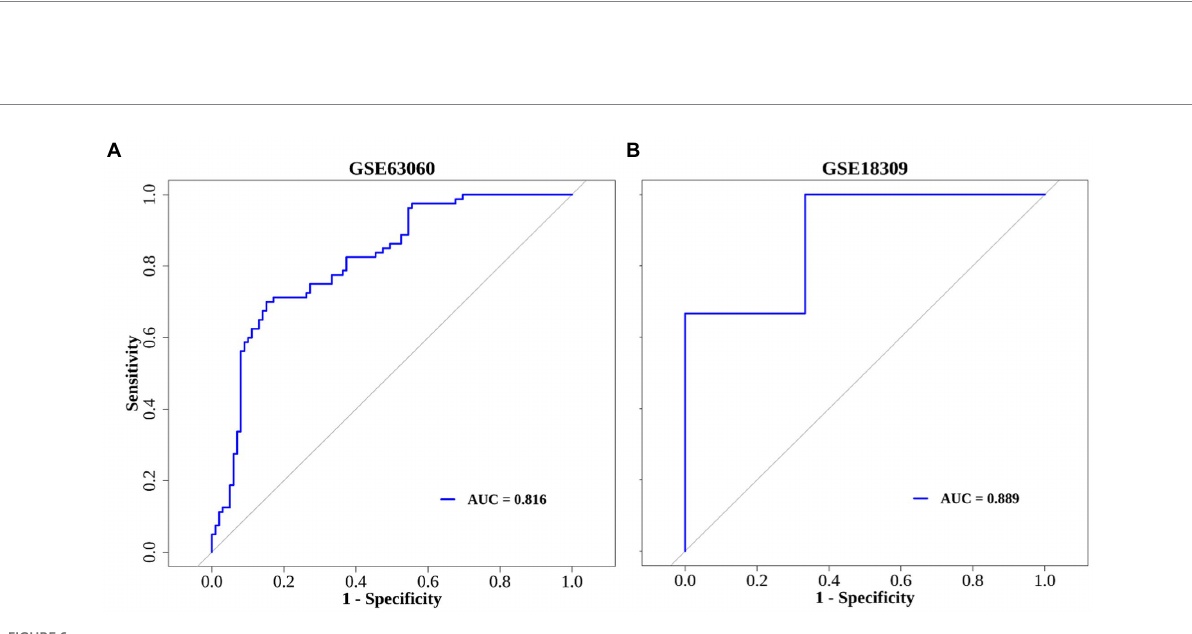
FIGURE 6 The ROC curve of diagnostic model. (A) GSE63060 dataset serves as the training set. (B) GSE18309 dataset serves as the validation